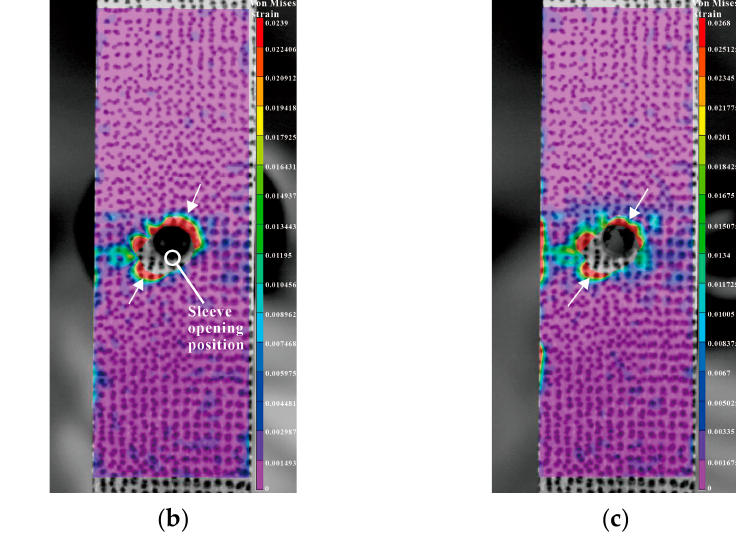
Figure 22. Change in von Mises strain on single-hole specimens during extrusion (Entry Plane): ( a ) before SSCE; ( b ) during SSCE; ( c ) after SSCE.